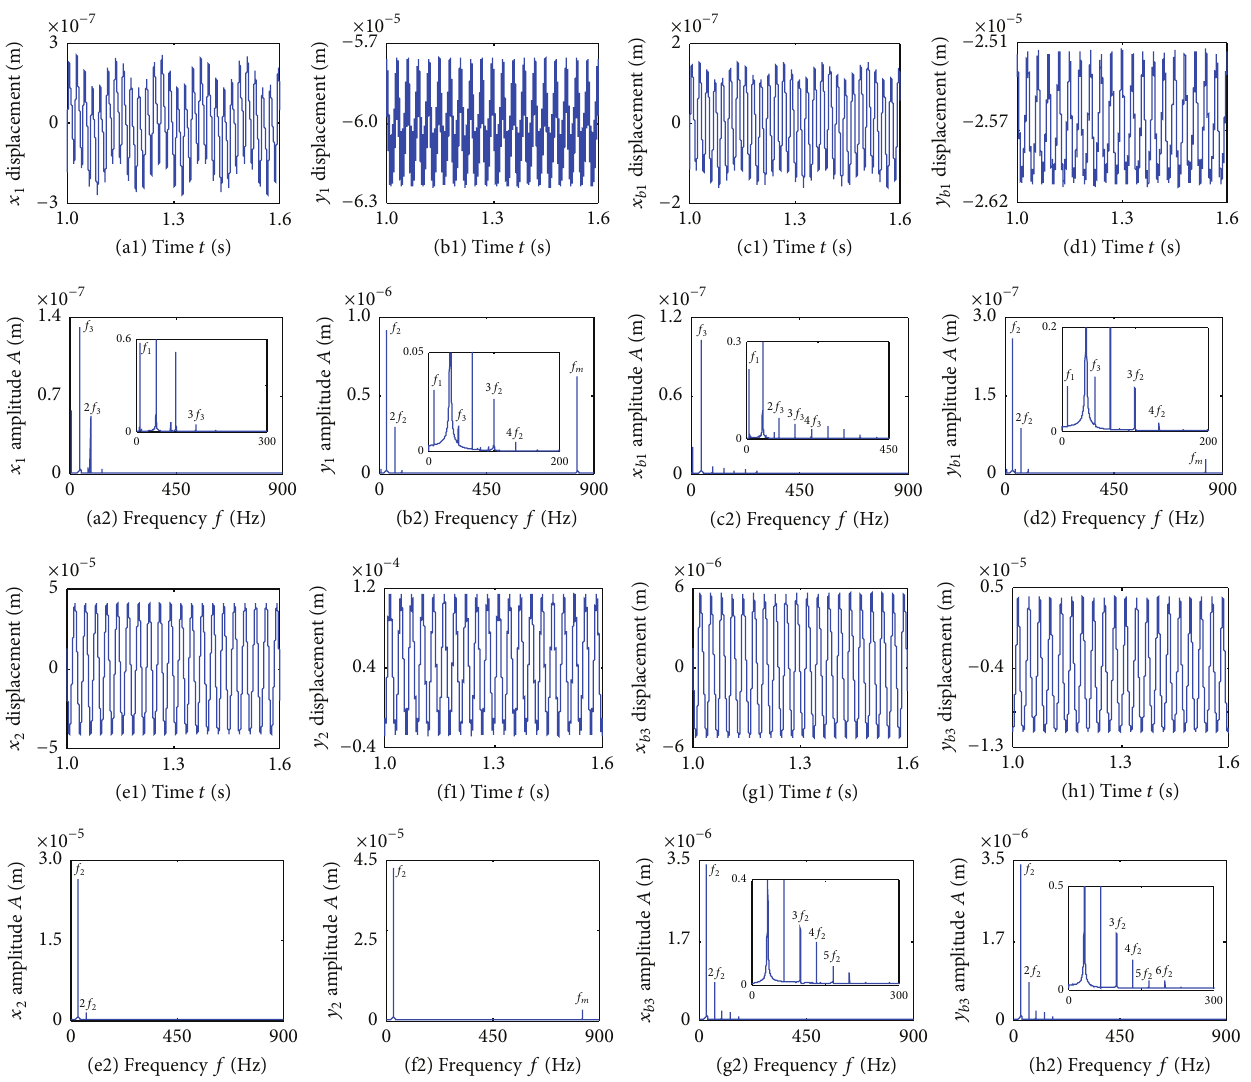
Figure 9: Waveform and spectrum diagram at 𝑛 1 = 500 r/min, 𝜌 1 = 4.0 × 1 0 −6 m, and 𝜌 2 = 4.0 × 1 0 −5 m.